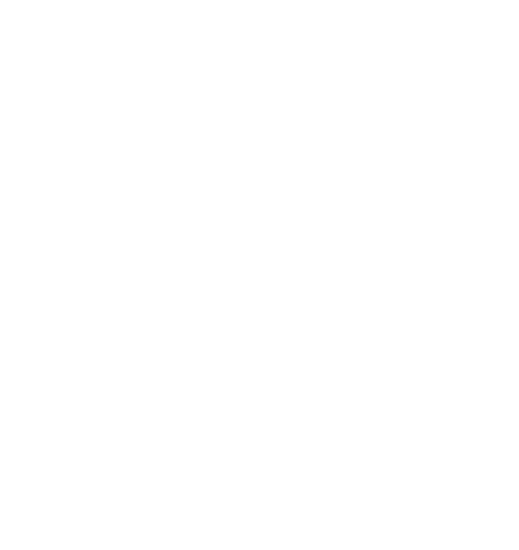
Figure 1. A flow chart illustrating the localised learning algorithm of KNN-LS-SVM for regression (adapted from ref.